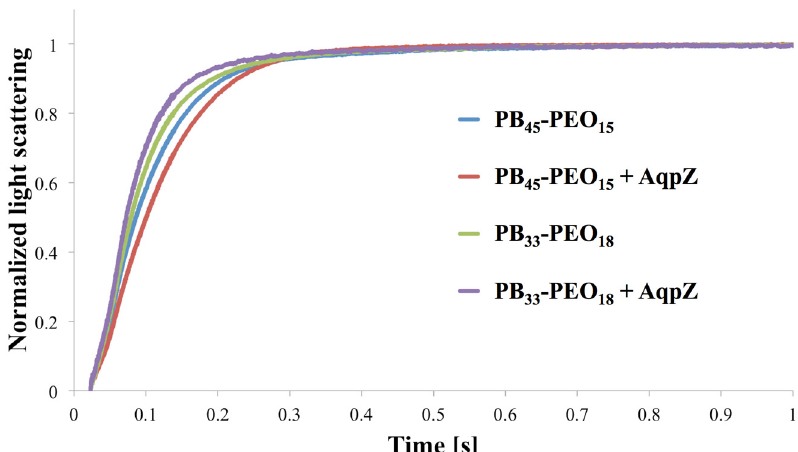
Figure 4. Normalized light scattering vs. time for proteo- and polymersomes of PB 45 -PEO 14 and PB 33 -PEO 18 at an mPAR of 1:100. For PB 45 -PEO 14 the apparent water permeability is slightly decreased for the proteopolymersomes versus polymersomes, whereas for PB 33 -PEO 18 it is slightly